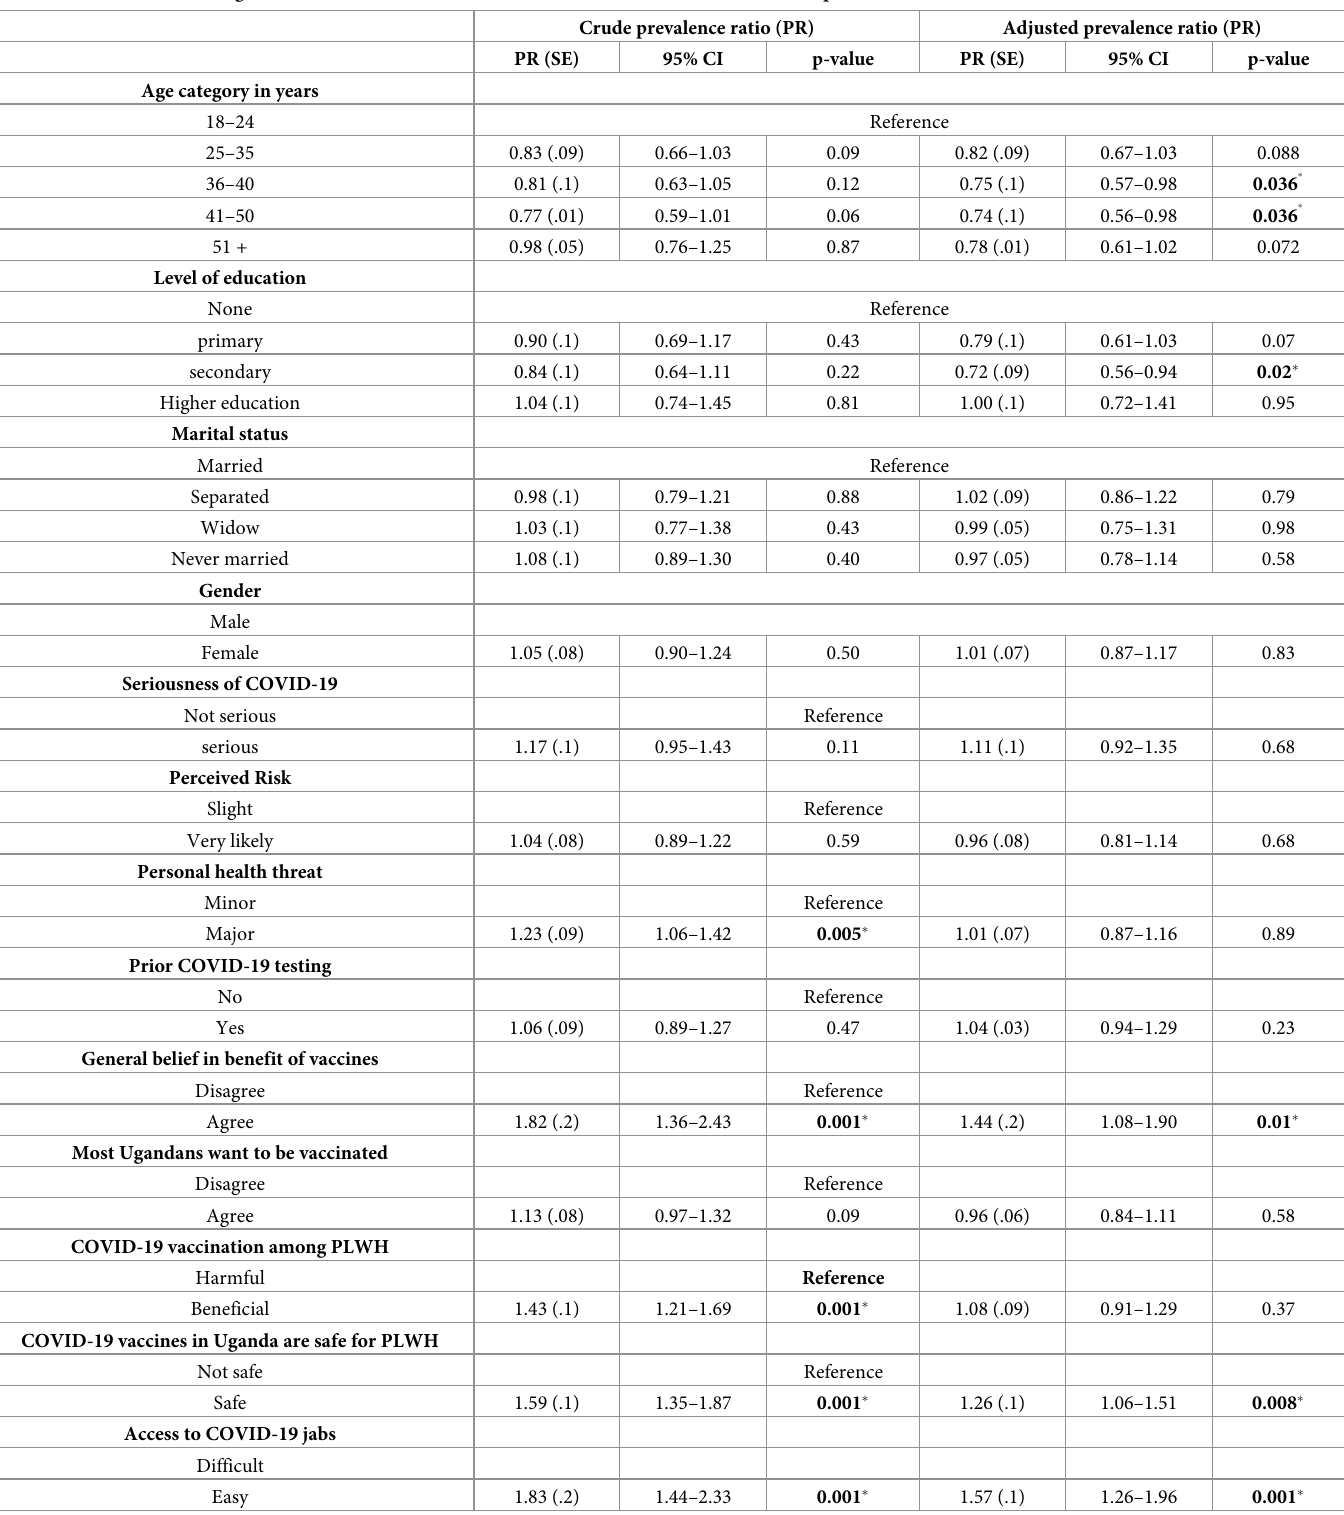
Table 5. Modified Poisson regression multivariable model for association of COVID-19 vaccine